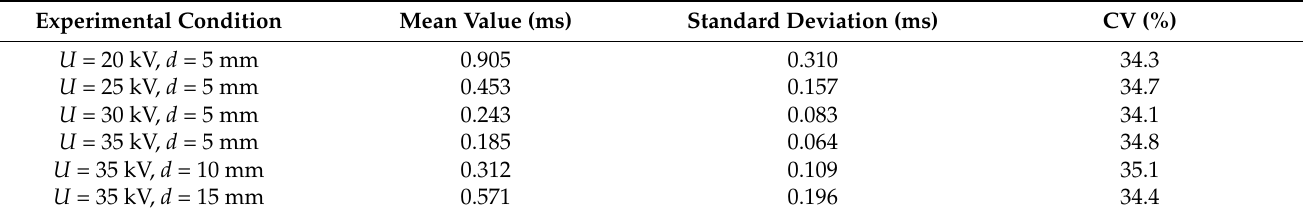
Table 4. Correlation between the mean and standard deviation of the measured t in .